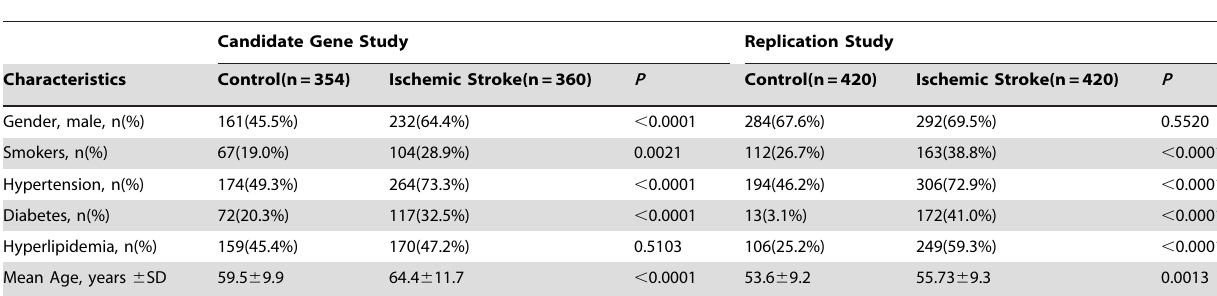
Table 1. Baseline Characteristics of Control Subjects and Ischemic Stroke Patients.